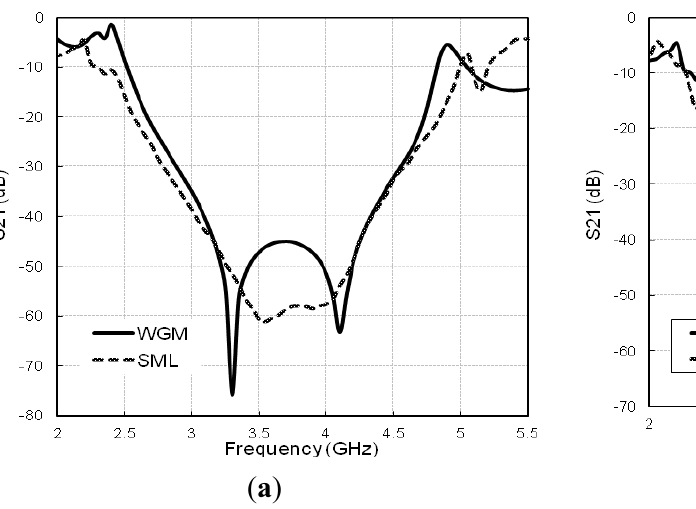
Figure 4. ( a ) Transmission responses of the MBHIES from two different methods; ( b ) Simulated and measured transmission responses, S